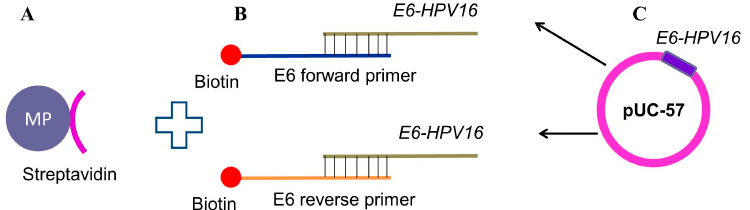
Figure 4. Scheme of DNA nanoconstruct of biotin-modified oligonucleotides bound to E6-HPV16 oncogene joined to streptavidin modified MPs : ( A ) 100 µL (10 mg·mL − 1 ) of commercial Dynabeads M-280 Streptavidin MPs; ( B ) E6-HPV16 complementary oligonucleotides biotinylated (forward